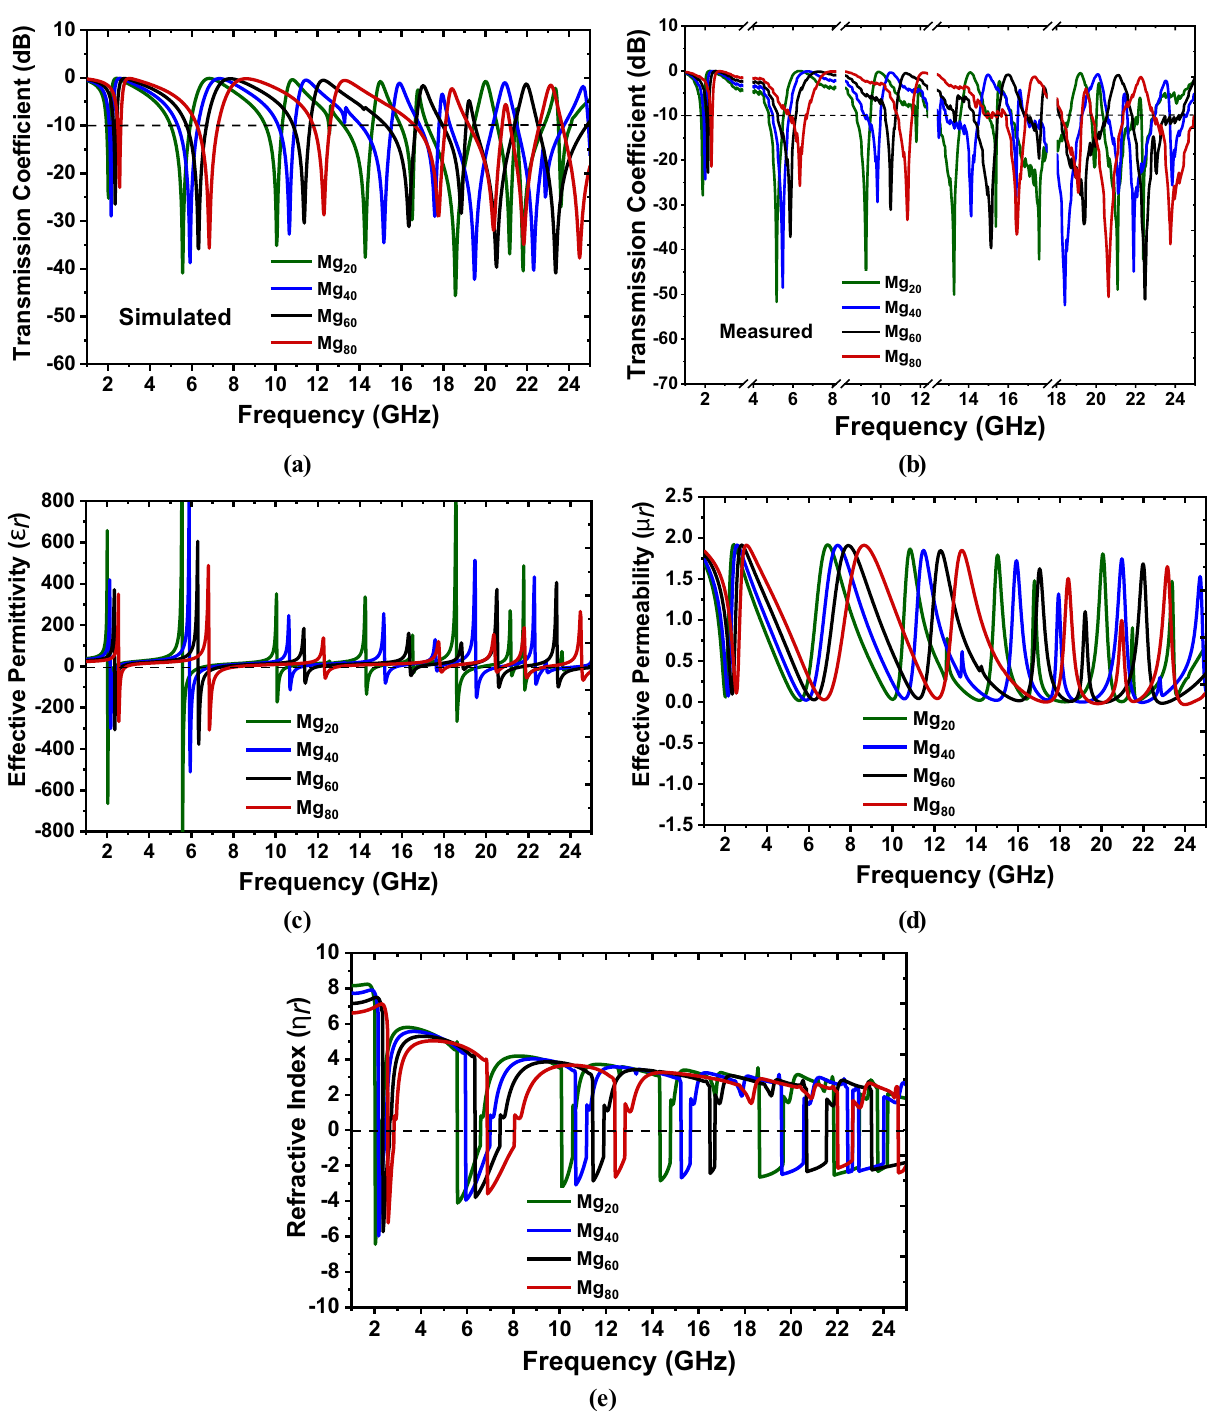
Figure 11. The amplitude of ( a ) the simulated transmission coefficient, ( b ) the measured transmission coefficient, the extracted effective ( c ) permittivity, ( d ) permeability, and ( e ) refractive index for all four concentration of magnesium Mg 20 , Mg 40 , Mg 60 , and Mg 80